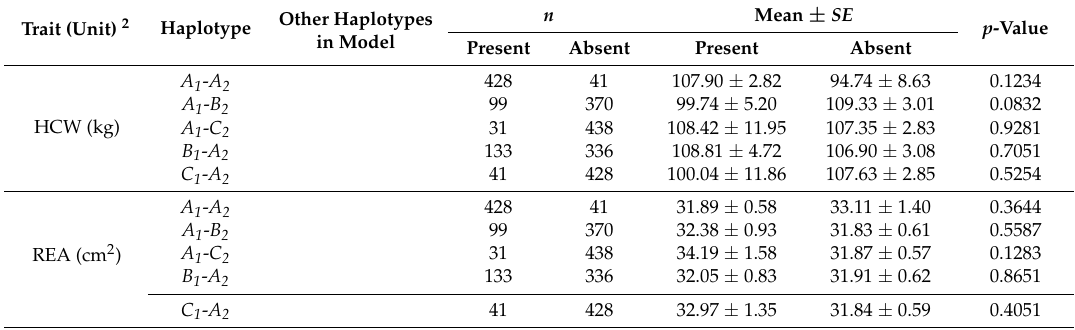
Table 4. Association of DGAT2 haplotypes with carcass and meat quality traits (mean ± SE ) 1 in yaks. Trait (Unit)